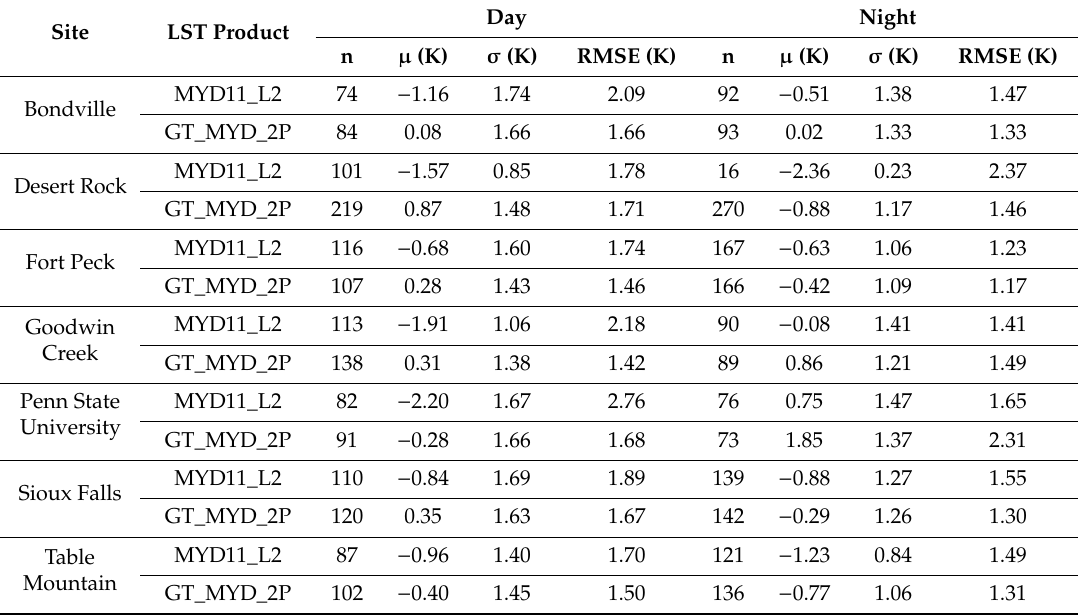
Figure 4. LST validation for the operational Aqua-MODIS Collection 5 Level-2 LST product (MYD11_L2) over seven SURFRAD validation sites: ( a ) Table Mountain, ( b ) Penn State University, ( c ) Bondville, ( d ) Desert Rock, ( e ) Goodwin Creek, ( f ) Sioux Falls, ( g ) Fort Peck; covering the year of 2011. Daytime matchups are in red, and nighttime matchups are in blue. Table 2. In situ validation statistics during 2011 for both GlobTemperature Aqua-MODIS LST retrievals (GT_MYD_2P) and operational Aqua-MODIS LST retrievals (MYD11_L2) with respect to the seven SURFRAD sites. Number of matchups (n), median ( µ ) di ff erences, robust standard deviations ( σ ) and root-mean-square errors (RMSEs) are presented for both day and night observations.